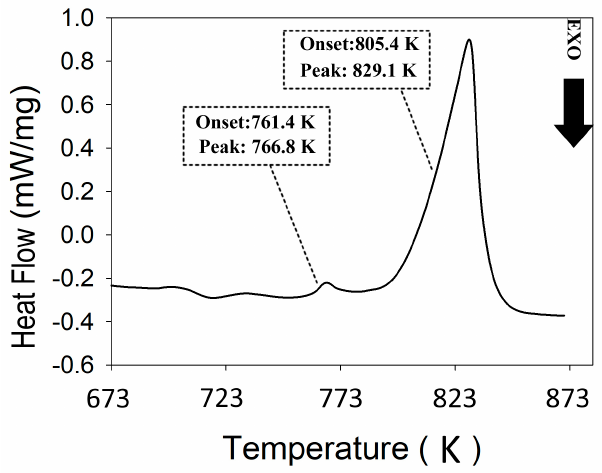
Figure 2. Thermogram obtained for the stoichiometric melting (SM) sample with the nominal ZnSb composition.